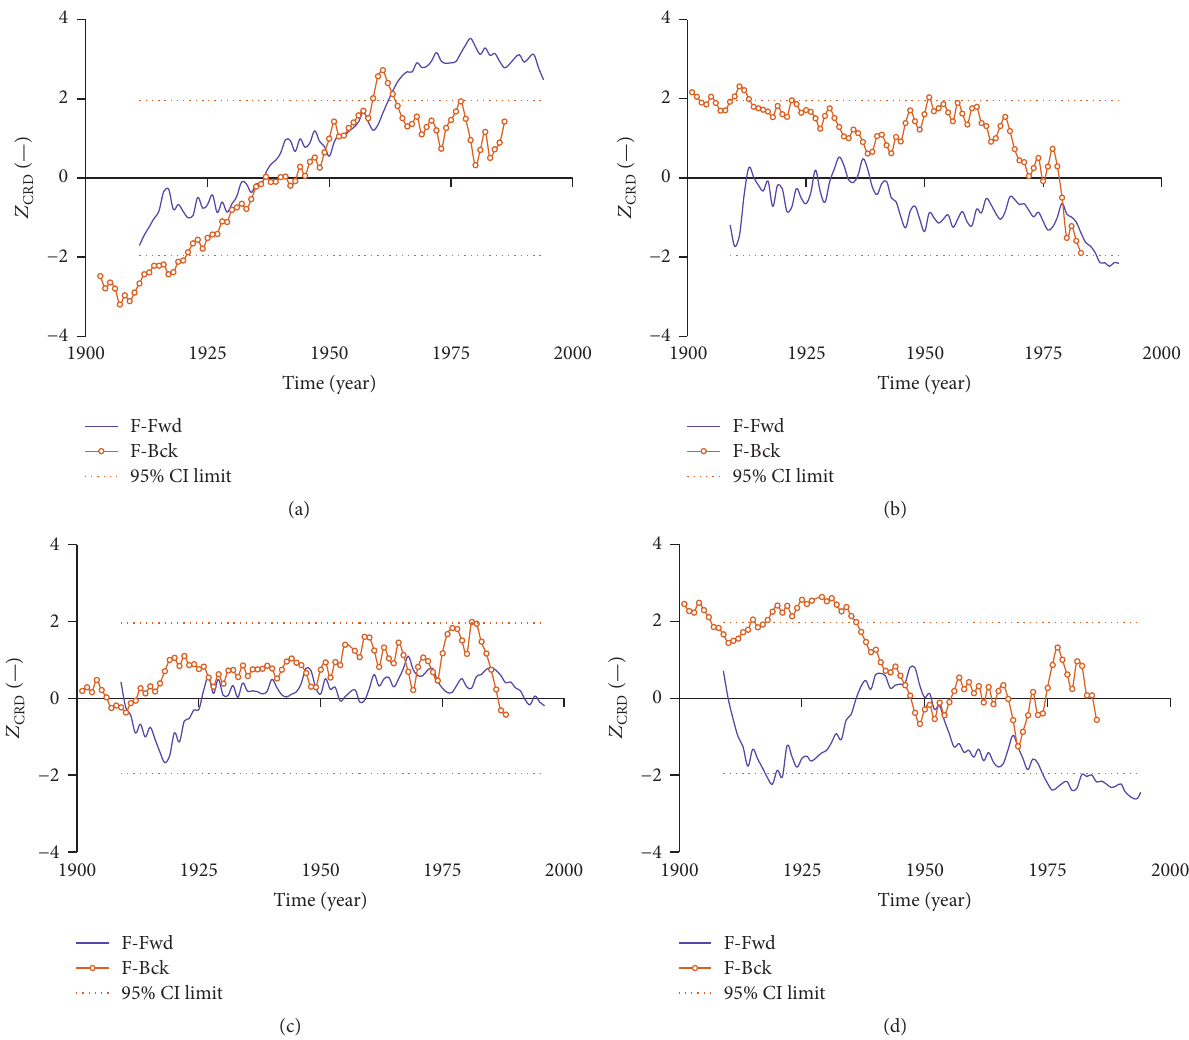
Figure 5: Trend evolutions obtained using moving window of flexible length slid in forward (F-Fwd) and backward (F-Bck) ways based on the annual rainfall at station: (a) 4, (b) 10, (c) 12, and (d)